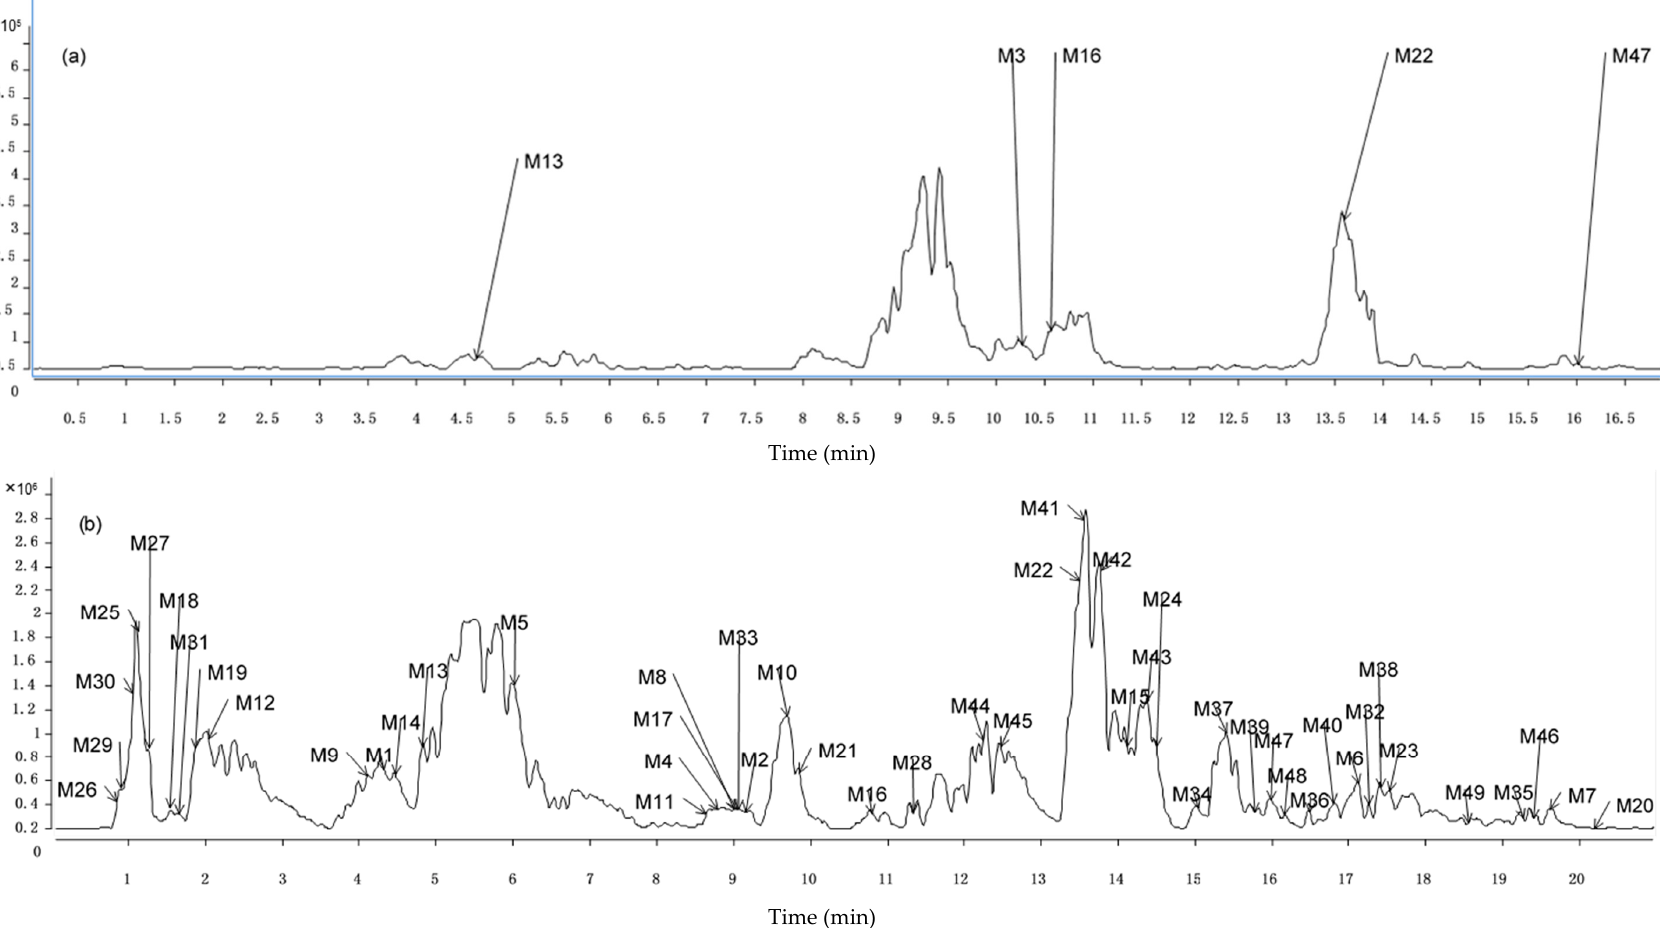
Figure 3. Base peak chromatograms (BPCs) with neutral loss scanning of 176 and 80 Da in negative mode to find constituents existing in ( a ) Rat plasma samples; ( b ) Rat urine samples.